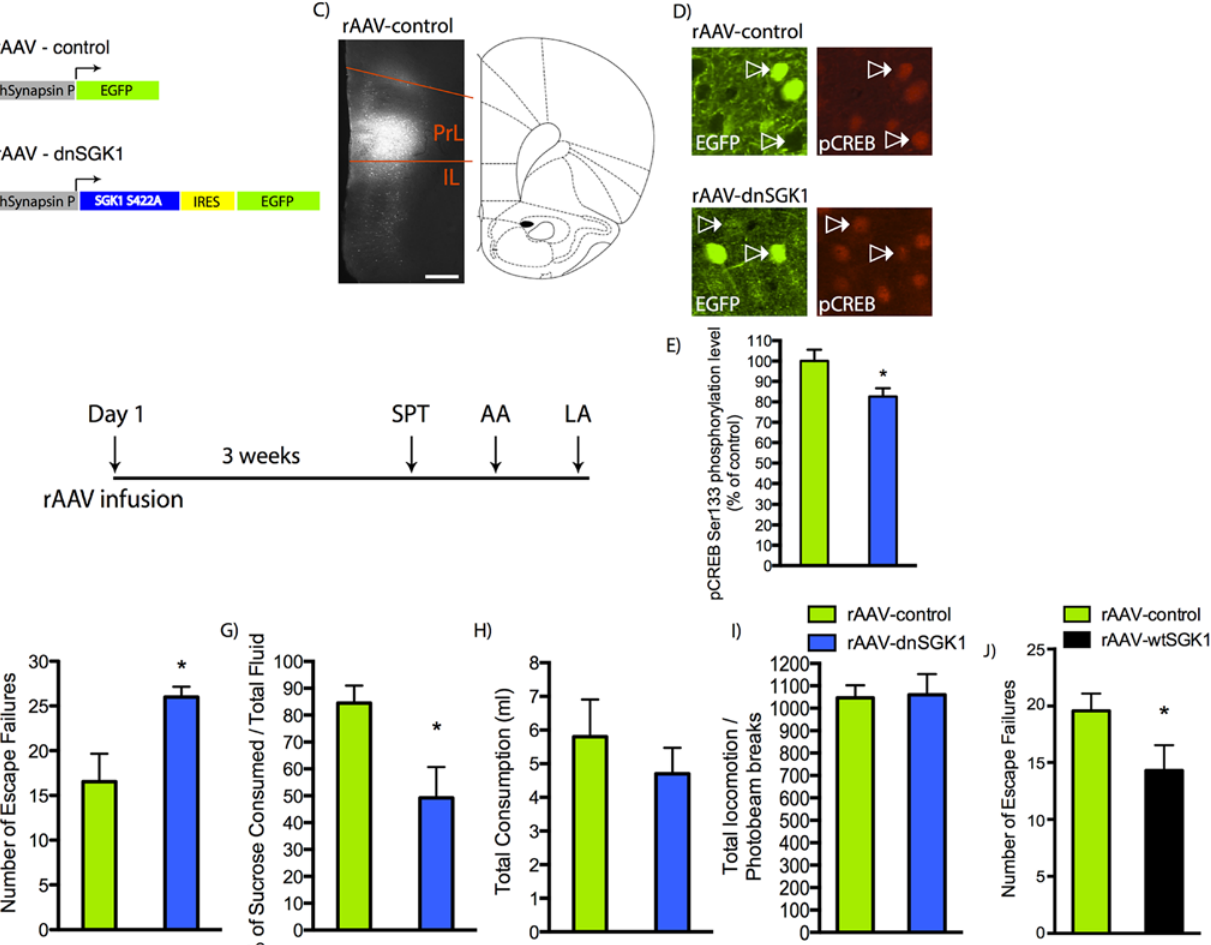
Fig 3. Viral expression of dnSGK1 increases escape failures. (A) rAAV construct used to express dnSGK1/EGFP or EGFP alone (control). ITR, inverted terminal repeats; IRES, internal ribosomal entry site. (B) Experimental timeline for behavioral analysis after bilateral mPFC infusions of rAAV-EGFP, rAAV- dnSGK1, or rAAV-wtSGK1. SPT, sucrose preference test; LA, locomotor activity. (C) Shown is a representative low-power magnification of green fluorescent protein (GFP) expression in the medial PFC after infusion of rAAV-dnSGK1. Expression was observed in the prelimbic (PrL) and infralimbic (IL) regions of the medial PFC. Scale bar = 500 μ m. (D) Colocalization of dnSGK1 and phospho-CREB (pCREB) in the prefrontal cortex: pCREB Ser133 immunostaining in rat PFC from animals infused with rAAV-control and rAAV-dnSGK1. (E) Quantification of pCREB-positive cells showed an 18% reduction in the dnSGK1-overexpressing group (rAAV-control, n = 16 neurons; rAAV-dnSGK1, n = 16 neurons; two rats per group). Data are mean ± SEM percent change over control group. (rAAV-control 100 ± 5.58; rAAV-dnSGK1 82.55 ± 4.09.) (t(30) = 2.094, * p < 0.05, Student ’ s t test.) Effects of rAAV-dnSGK1 infusion into medial PFC on behavior were tested in (F) AA (escape failures), (G) sucrose preference, (H) total fluid consumption, and (I) locomotor activity. Data are shown as mean ± SEM (controls n = 11; dnSGK1 n = 9). (t(18) = 2.61 for AA and t(18) = 2.795 for SPT, Student ’ s t test, * p < 0.05]. (J) AA (escape failures) for rAAV-wtSGK1 injected rats (controls n = 10; wtSGK1 n = 10). (t(18) = 1.933, one-tailed Student ’ s t test, * p < 0.05.) For underlying data, see S1 Data.